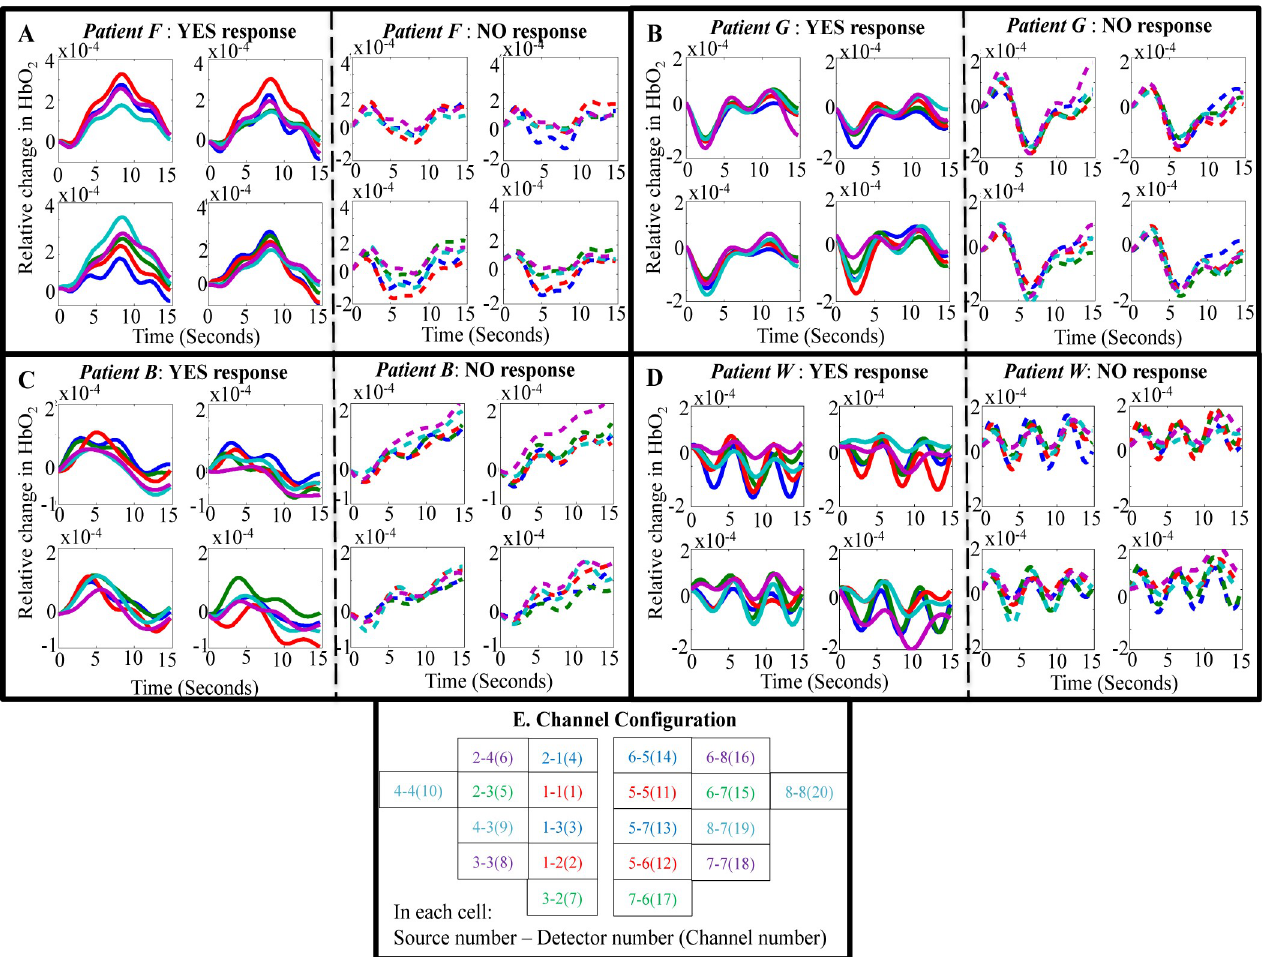
Fig 1. The averaged relative change in O2Hb corresponding to “yes” and “no” sentence interstimuli interval (ISI). (A) Patient F, (B) patient G, (C) patient B, and (D) patient W. (E) Channel configuration: Eight sources and eight detectors placed on the frontocentral brain region translated into 20 channels, 10 on each side of each hemisphere. For clearly displaying the relative change in O2Hb, 10 channels on each side of hemisphere were further subdivided in groups of 5 channels—i.e., 20 channels were divided into four groups, each consisting of 5 channels. In each subplot, the x-axis is time in seconds and the y-axis is relative change in O2Hb, and the five different colored lines correspond to relative change in O2Hb across 5 different channels, as depicted in the channel configuration map. Fig 1 data is located at https://doi.org/10.5281/zenodo.1419151; https://doi.org/10.5281/zenodo.192386; https://doi.org/10.5281/zenodo. 192388; https://doi.org/10.5281/zenodo.192390; https://doi.org/10.5281/zenodo.192391.